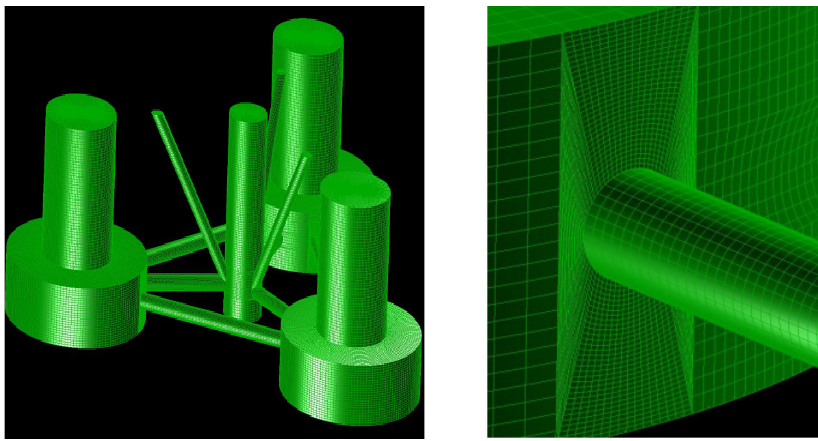
Figure 8. MultiSurf model of the SNL semi-submersible